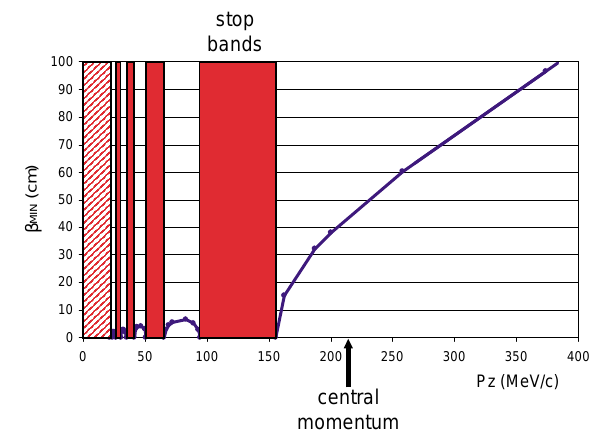
FIG. 1. (Color) Minimum b function for the FOFO channel as a function of P z . limited by the magnetic aperture of 1.36 m diameter re-